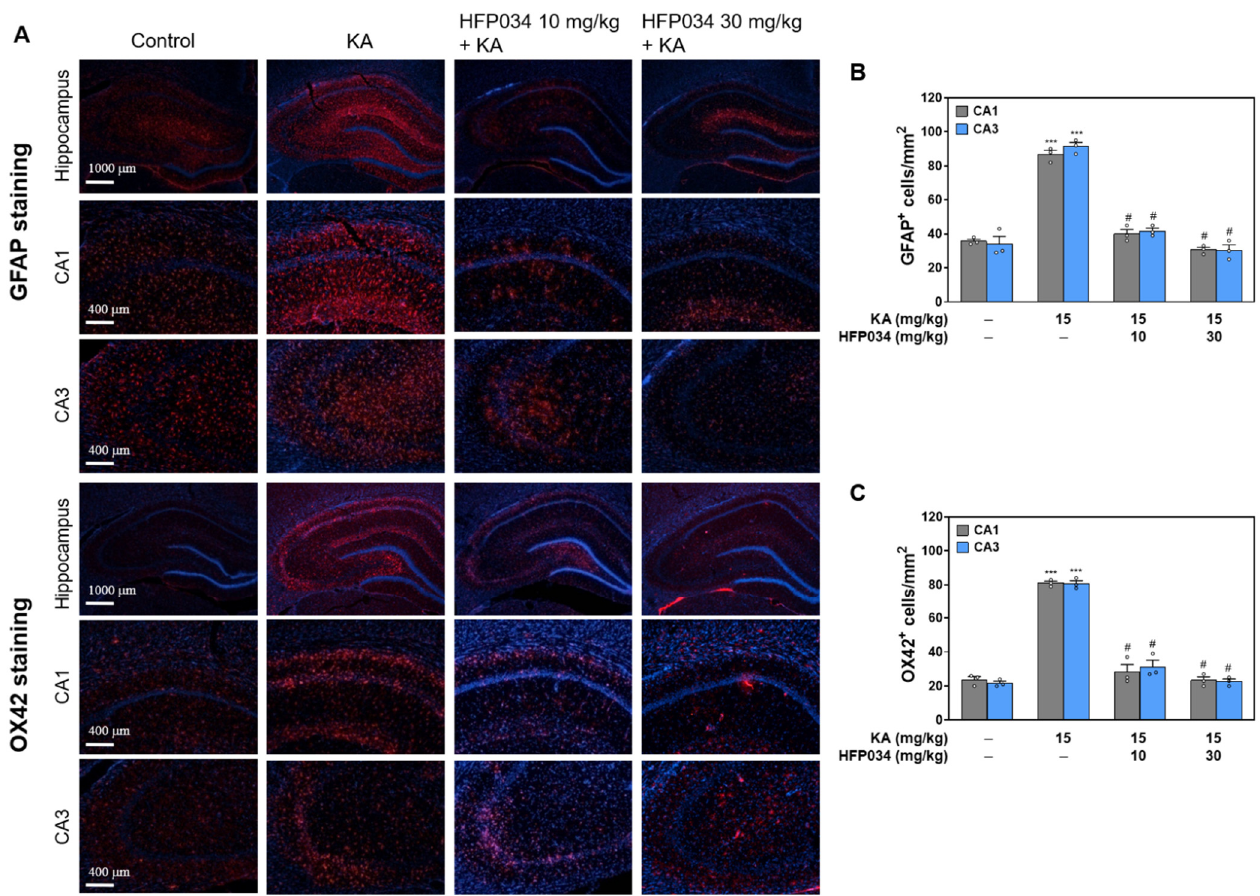
Figure 7. Effect of HFP034 pretreatment on the activation of microglia and astrocyte in the hippocampus of rats with KA. ( A ) Representative images of OX42 and GFAP staining at 3 d after i.p. KA. ( B , C ) Quantitative data of A and C showing the number of OX42 + and GFAP + cells in the hippocampal CA1 and CA3 regions. Each dot represents the value for an individual experiment. Data are presented as mean ± S.E.M. n = 3 rats for each group. *** p < 0.001, versus control group. # p < 0.001, versus KA group.